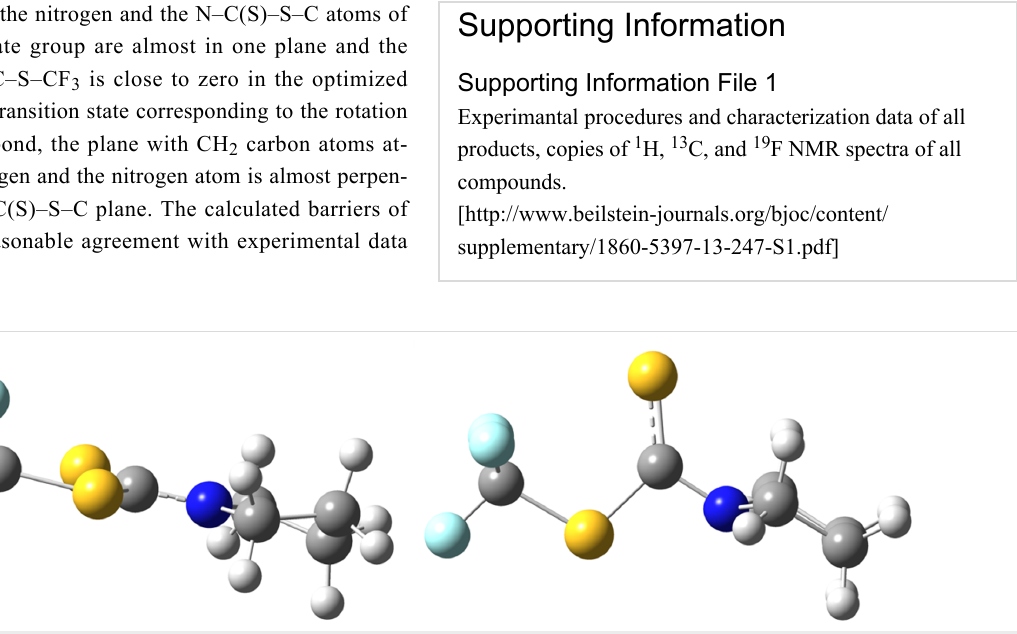
Figure 3: The optimized structure of compound 4b (left) and the transition state structure for the rotation around the N–C bond (right).